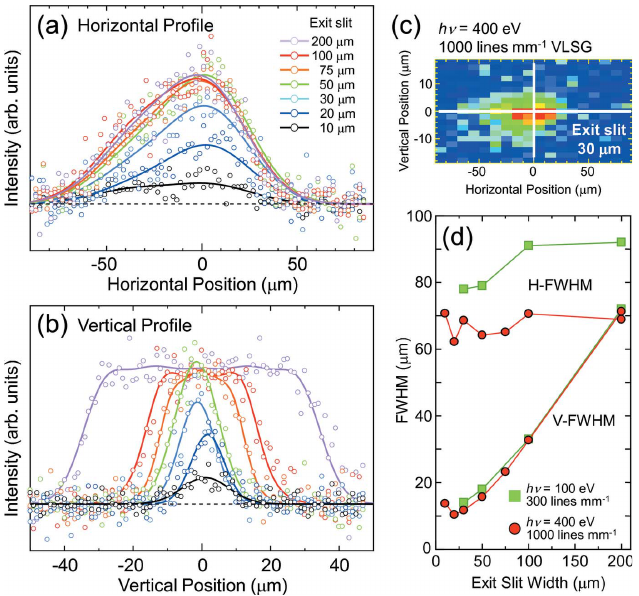
Figure 6 Exit-slit dependence of beam profiles in ( a ) the horizontal and ( b ) the vertical directions. The horizontal linear polarized light with energy of 400 eV was used. The beam profiles were acquired by 1D scans along the white lines in the panel ( c ), which shows a beam spot obtained by a two- dimensional scan. The open circles are the measured data and solid lines are results of least-squares fitting by single or multiple Gaussian functions. The H- and V-FWHMs are plotted in panel ( d ) for 400 and 100 eV light using circles and squares,